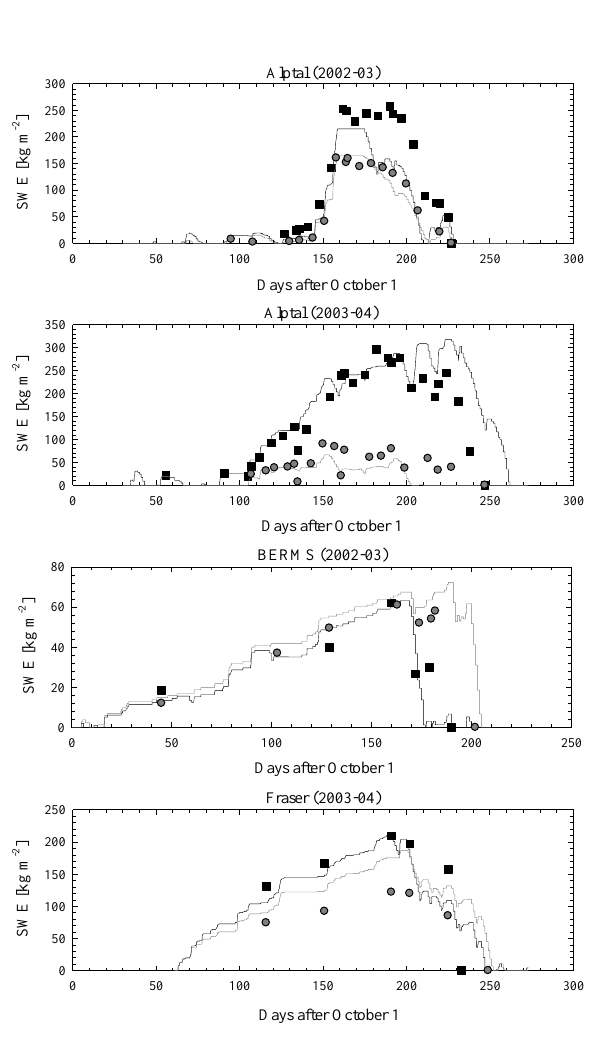
295 kg m − 2 . Large variations in SWE were also observed be- tween paired forest and clearings, with forest accumulations ranging from approximately 30% of the clearing accumula- tion at the Alptal location (2003–2004) to near even accumu- lations at the BERMS location. Simulated and observed mean and maximum SWE at all sites are shown in Fig. 3 with model performance in- dex values given in Table 2. Here, simulations exhibit a small systematic under-prediction of mean SWE for all sites (MB=0.97), with a slightly greater under-prediction for